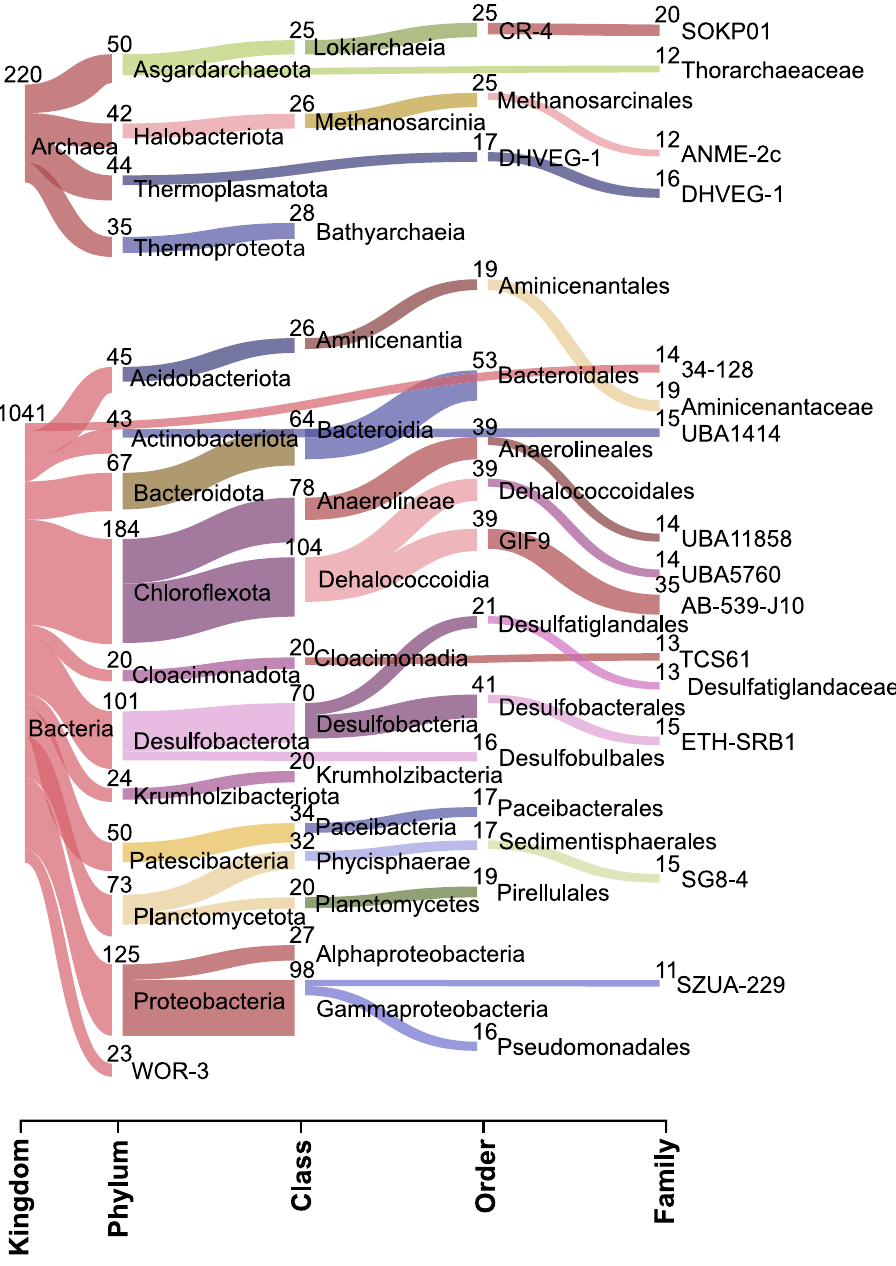
Fig. 1 | Classi fi cation ofspecies-level genomesrecoveredfromglobalcold seep sediment metagenomes. Sankey diagram based on assigned GTDB taxonomy showing recovered archaeal and bacterial MAGs at different taxonomic levels,